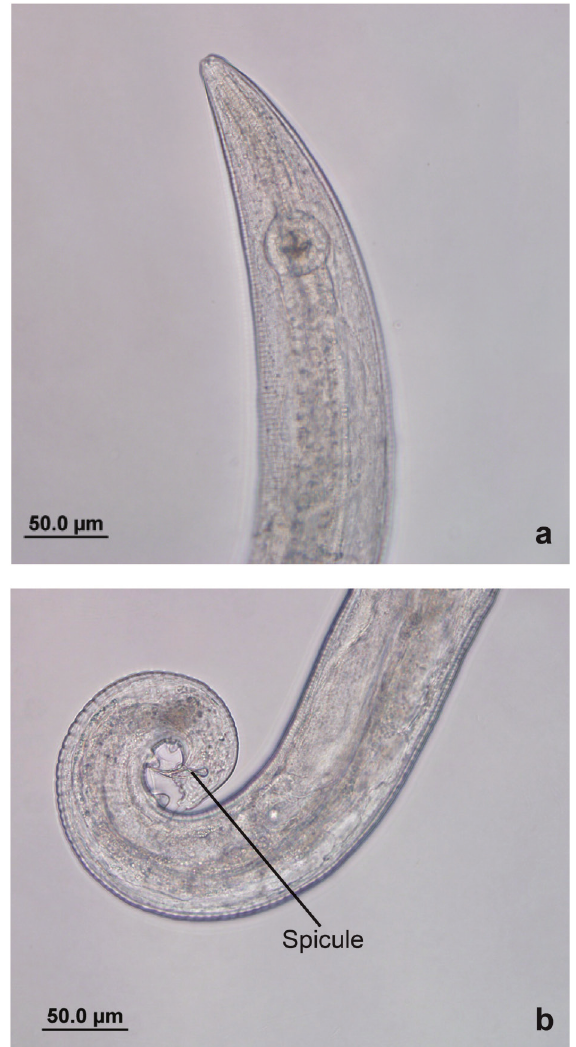
Figure 2 - Binema korsakowi . a. Male, cephalic region. b. Posterior region (line showing the